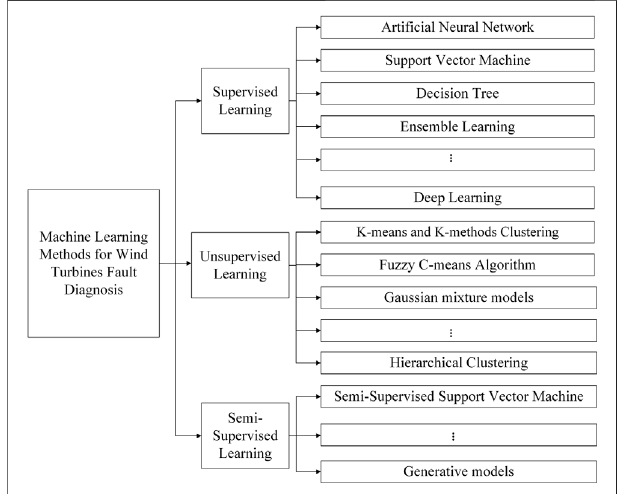
FIGURE 2 | ML methods for WT fault